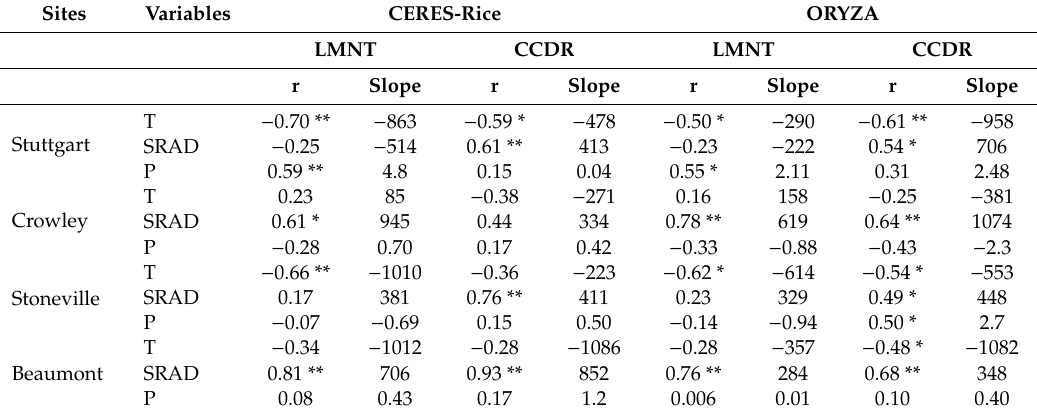
Table 5. Correlation coe ffi cient (r) and slope (m) from the linear regression of simulated yield